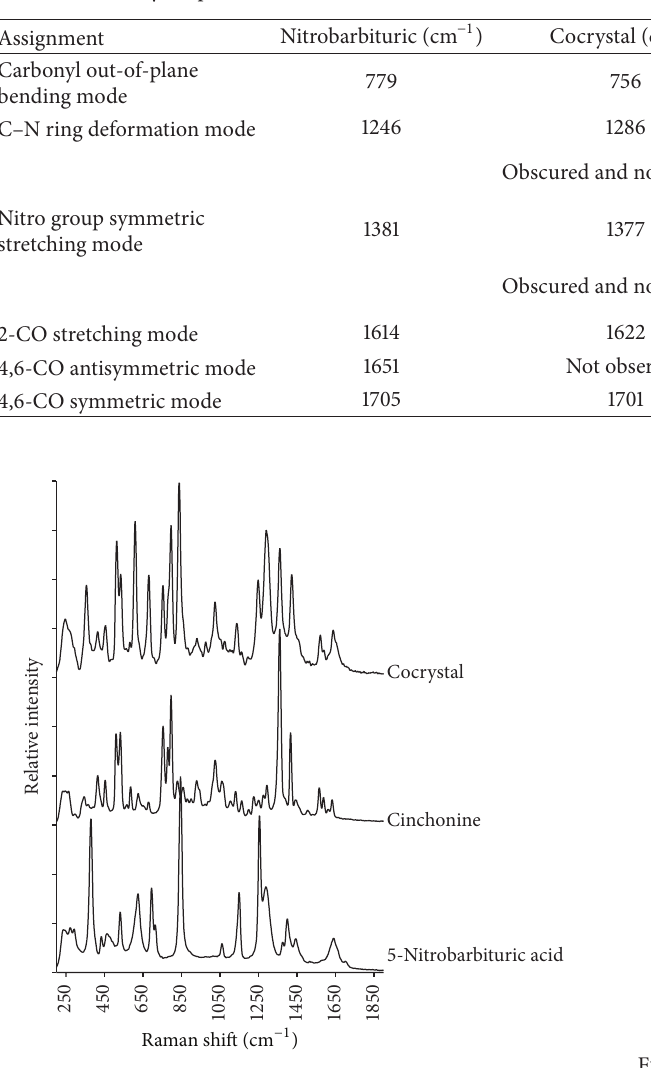
Figure 4: Infrared absorption spectra within the fingerprint region of 5-nitrobarbituric acid, cinchonine, and the 1:1 nitrobarbituric- cinchonine cocrystal.